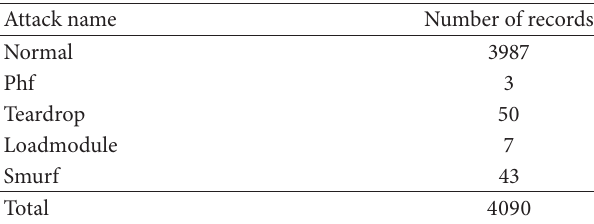
Table 1: Datasets used in the